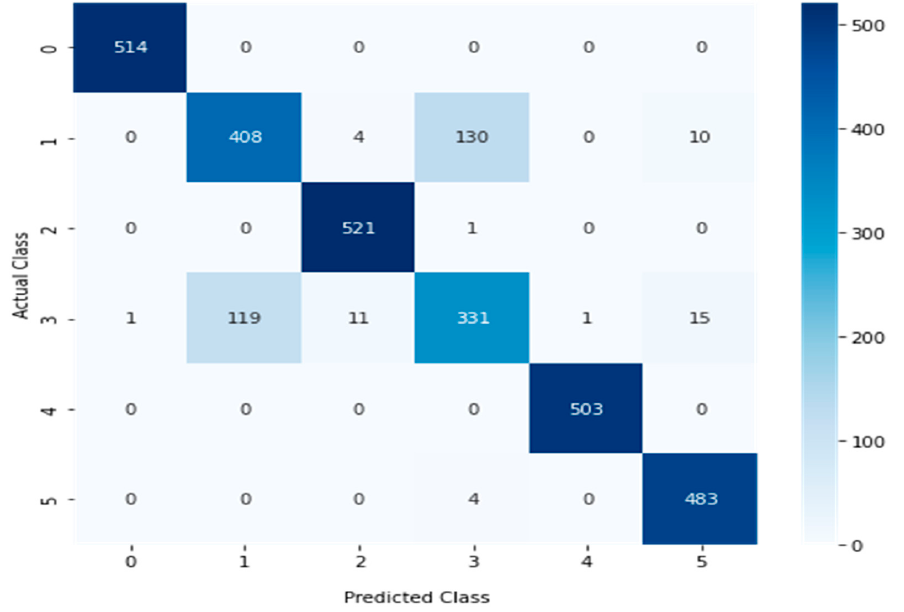
Figure 21. Confusion matrix of logistic regression.